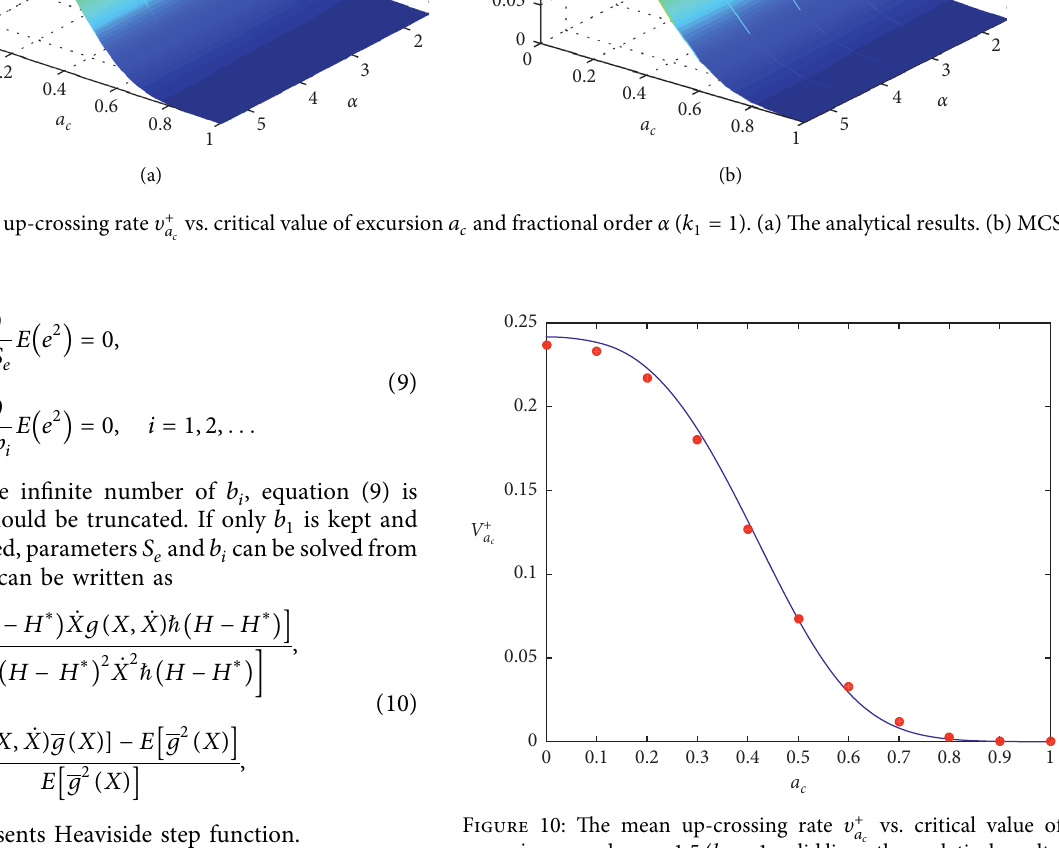
a c vs. critical value of excursion